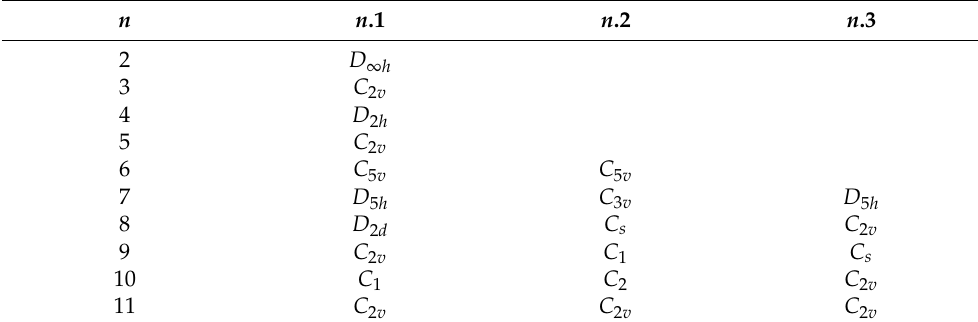
Figure 2. Optimized geometries of of Ag n ( n = 8–11) clusters as obtained with the DFT calculations. The labels refer to the energetic ordering according to the EAM calculations. Table 1. Point groups of the optimized Ag n clusters as obtained with the DFT calculations. n .1, n .2, and n .3 represents the results for the energetically lowest, 2nd lowest, and 3rd lowest isomer, respectively, from the EAM—and not the